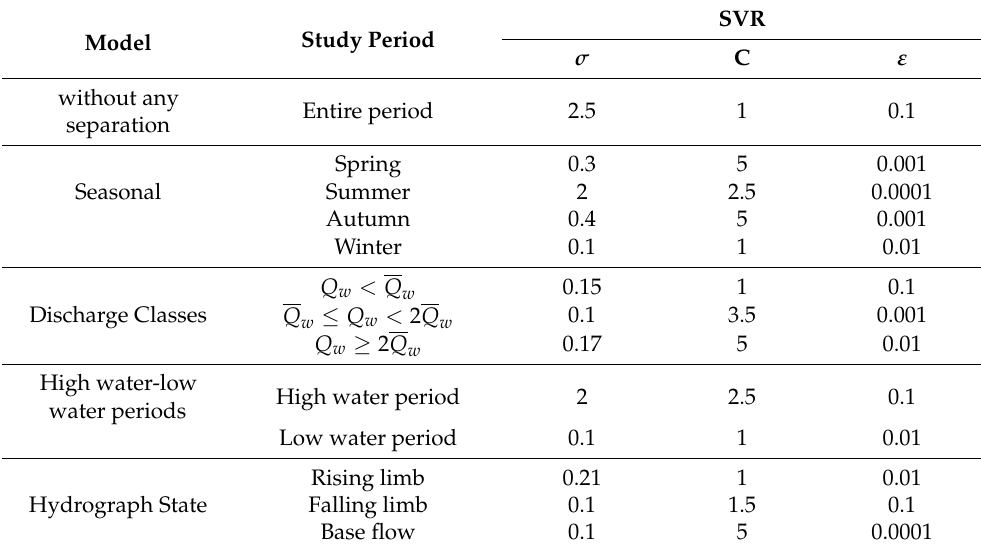
Table 7. Optimal values for the parameters of the SVR model 4